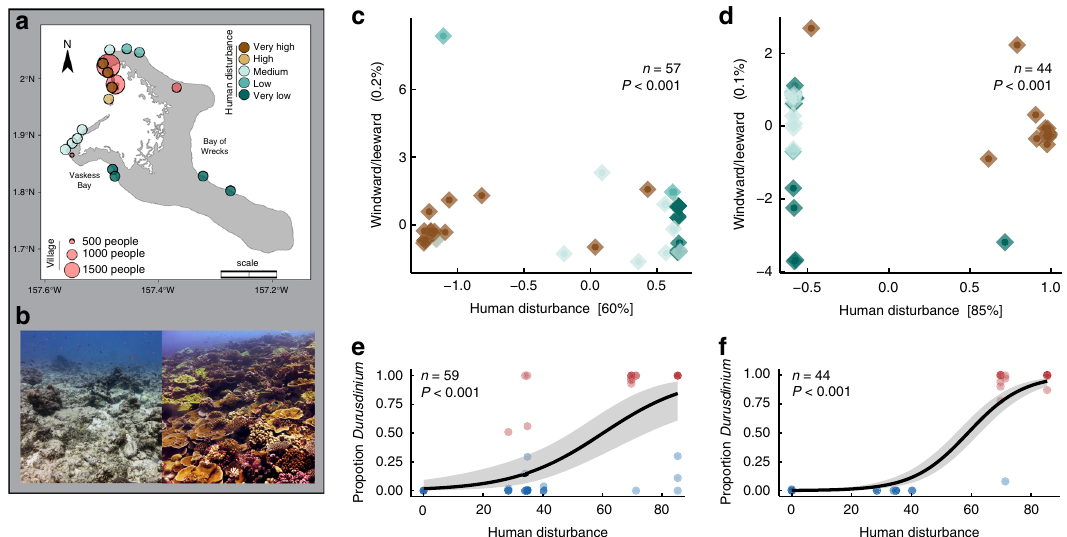
Fig. 1 Chronic local human disturbance and coral symbiont assemblages. a Reef sites on Kiritimati (central equatorial Paci fi c) with tagged coral colonies, categorized by intensity of human disturbance. Entire scale bar shows 10 km. b Examples of Kiritimati ’ s reefs at very high (left) and very low (right) disturbance sites, prior to the 2015 – 2016 El Niño. For Platygyra ryukyuensis ( c , e ) and Favites pentagona ( d , f ): c , d Constrained ordination of amplicon sequence variants (ASVs) showing signi fi cant effects of human disturbance on symbiont communities, prior to the heat stress. Colors correspond to a . Values in square brackets show variation explained by each constrained axis; exposure (windward vs. leeward side of atoll) had no effect. e , f Logistic regressions showing the impact of human disturbance on the prevalence of Durusdinium . Blue dots indicate Cladocopium -dominated colonies, while red dots indicate Durusdinium -dominated colonies. Differences in sample size ( c , e ) re fl ect different sequencing depth thresholds used for analyses. Grey shading in e , f shows 95% CI. Sample sizes indicate individual coral colonies sampled before the